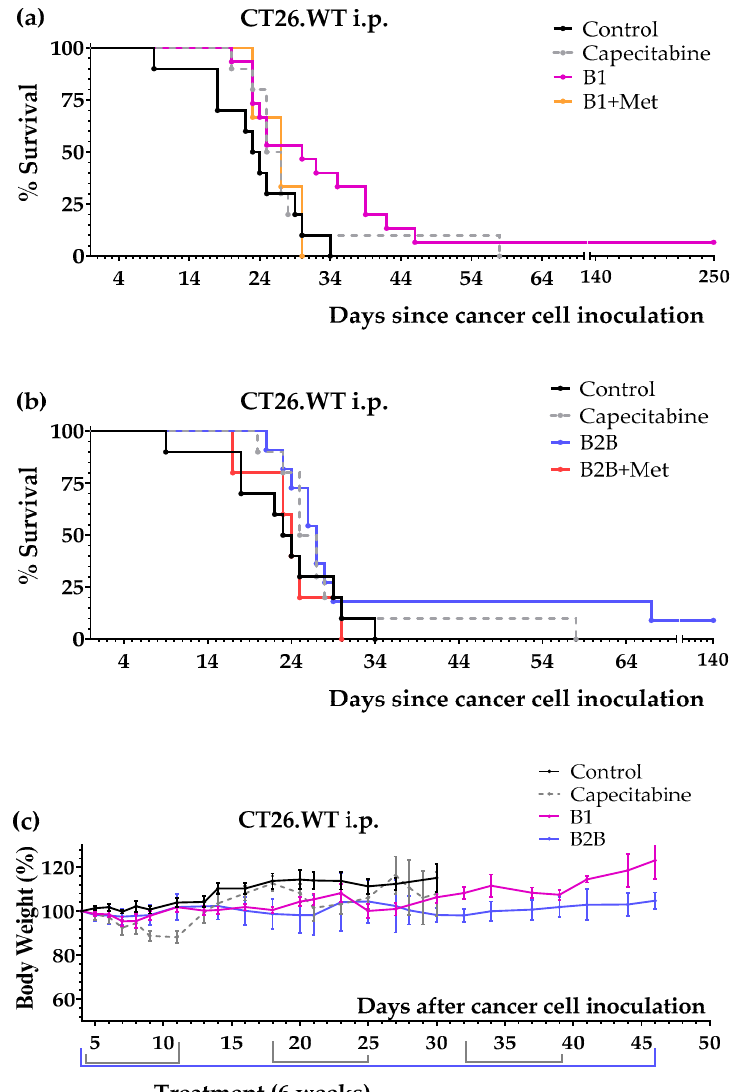
Figure 4. Anticancer effect of several artificial diets and capecitabine in mice with metastatic colon cancer (CT26.WT murine colon cancer cells inoculated in the peritoneum of immunocompetent BALB/c mice; peritoneal dissemination model). ( a ) Survival of untreated mice (control), mice treated with oral capecitabine (450 mg/kg/day, 7/7 schedule, 2–3 cycles) and mice treated with diets B1 and B1+Met for 6 weeks. ( b ) Survival of untreated mice (control), mice treated with oral capecitabine and mice treated with diets B2B and B2B+Met for 6 weeks. ( c ) Body weights of the mice (mean percentage ± SEM) relative to body weights at the beginning of treatments (day